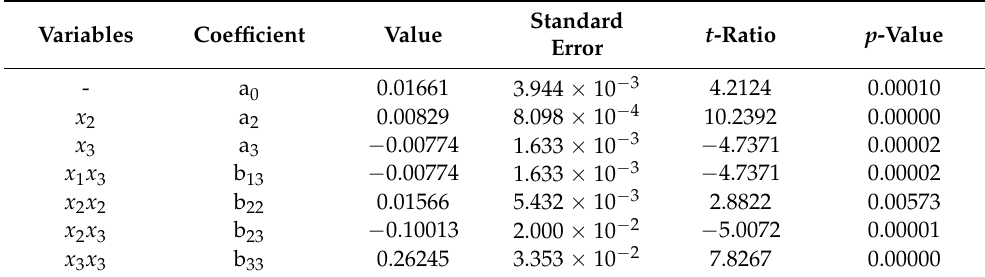
Table 5. Summary of regression coefficients for R f − 95